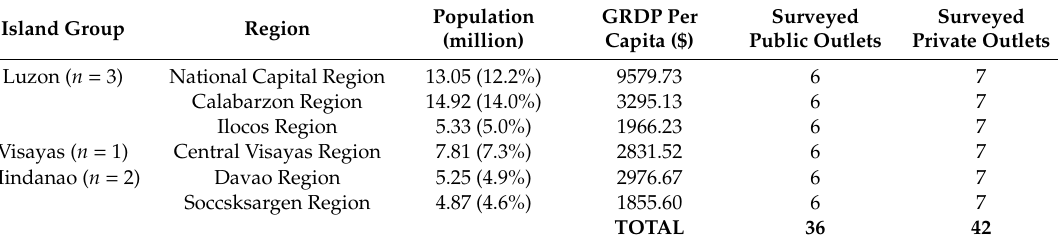
Table A1. Information of survey areas and number of sample facilities.